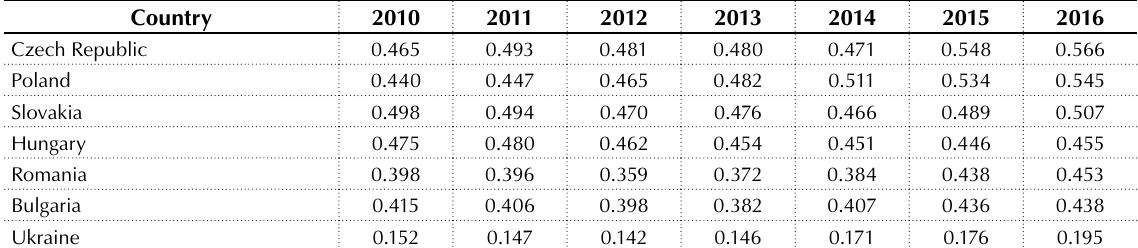
Table 1. Integral index of investment environment security of Ukraine and its Western neighbors (EU members) during